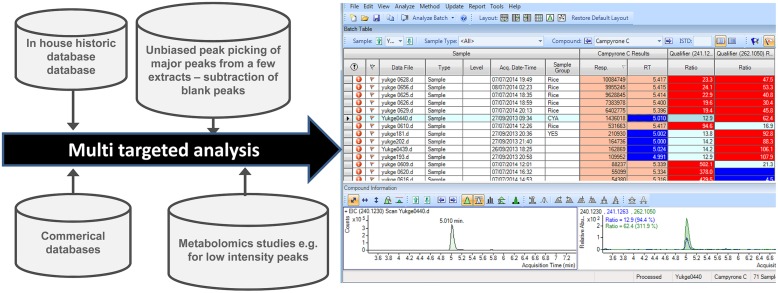
Suggested workflow in fungal natural products research depending on the problem, number of strains, species and of peaks are minor or major, as well as if it is as well-studied or new organism, the different data-parts may differ significantly.